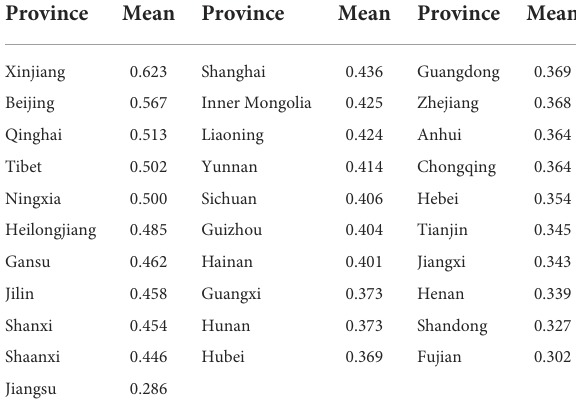
TABLE 2 Average health value of the population in each city and